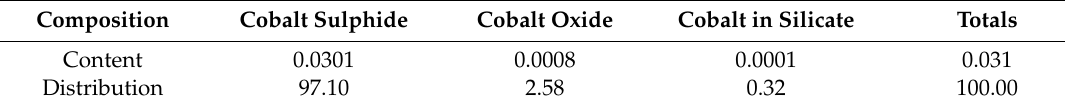
Table 2. Cobalt chemical phase analysis of cobalt containing V–Ti magnetite tailings (%).